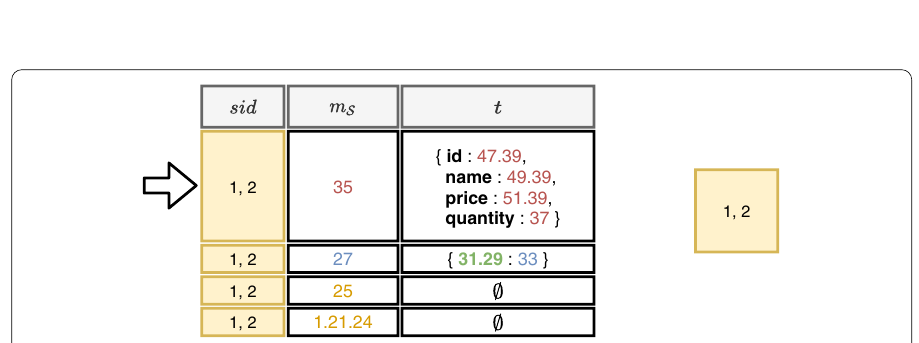
Fig. 10 Stack M and instance category I when the preparation phase for data from Fig. 7 is